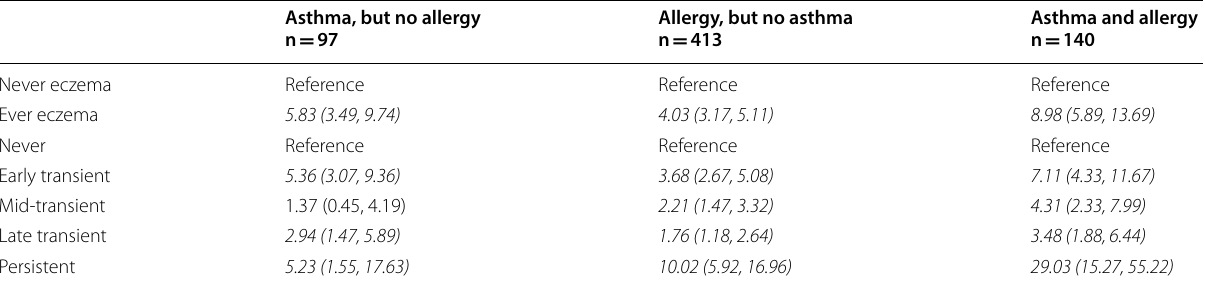
Values are odds ratios (95% confidence intervals) from logistic regression models for never/ever eczema and average odds ratios (95% confidence intervals) from multinomial regression models after multiple sampling based on 150 imputed datasets for eczema phenotypes. Reference group is no asthma and no allergy (n 3627). n number of participants with information on at least 3 eczema measurements. Missing data on asthma and physician-diagnosed allergy was imputed. = = Full models were adjusted for parental history of allergy, asthma or eczema, maternal education, parity, child’s sex, ethnicity and breastfeeding. Italic values indicate statistical significance at the α 0.05 =